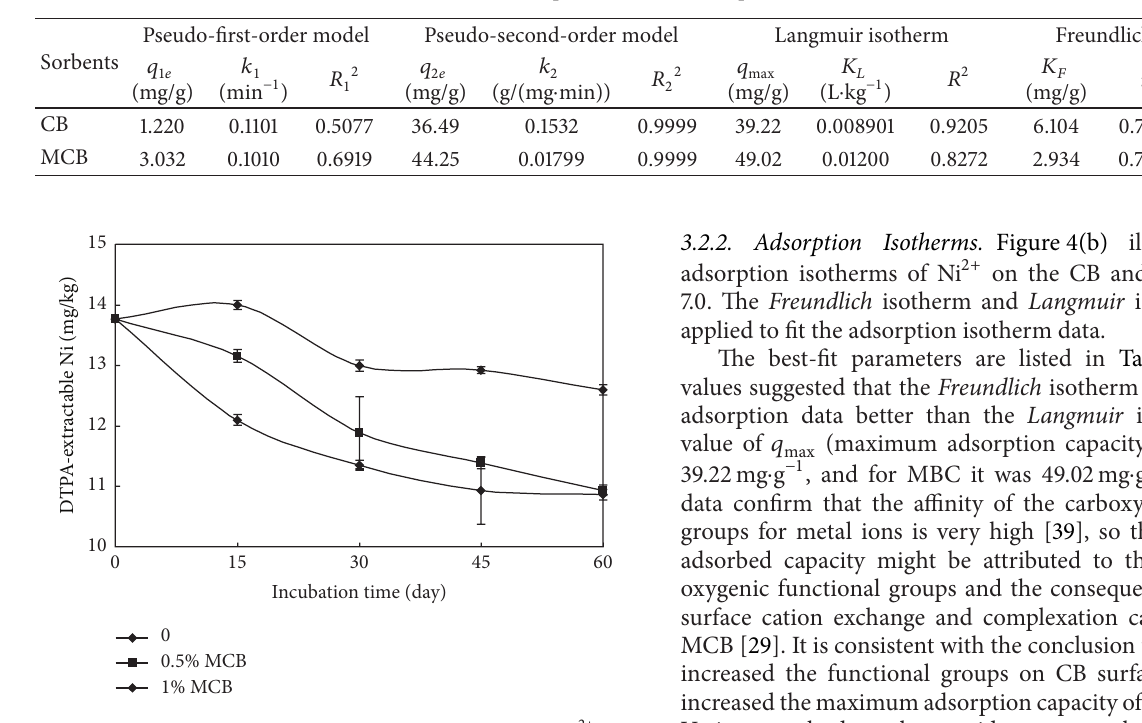
Figure 5: Effect of MCB on DTPA-extractable Ni in soil. Ni 2+ was added to soil at the ratio of 100mg ⋅ kg −1 and the MCB was added at the ratio of 0, 0.5%, and 1%, respectively.